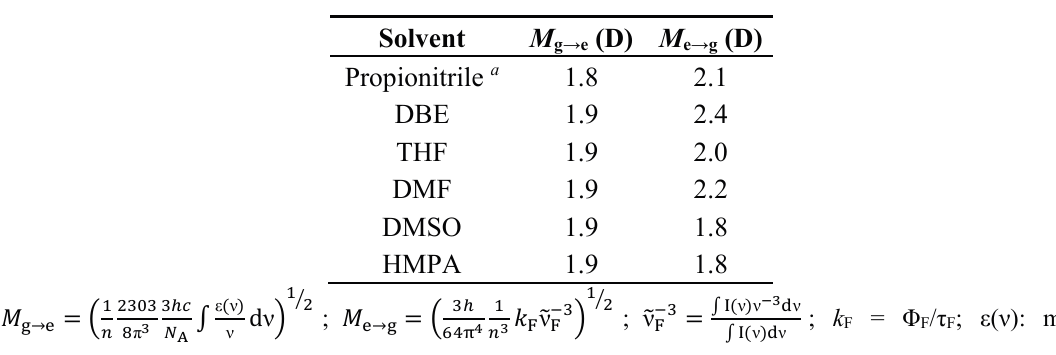
Table 4. 6AC transition dipole moments for absorption ( M g → e ) and emission ( M e → g ) in aprotic hydrogen-bond forming